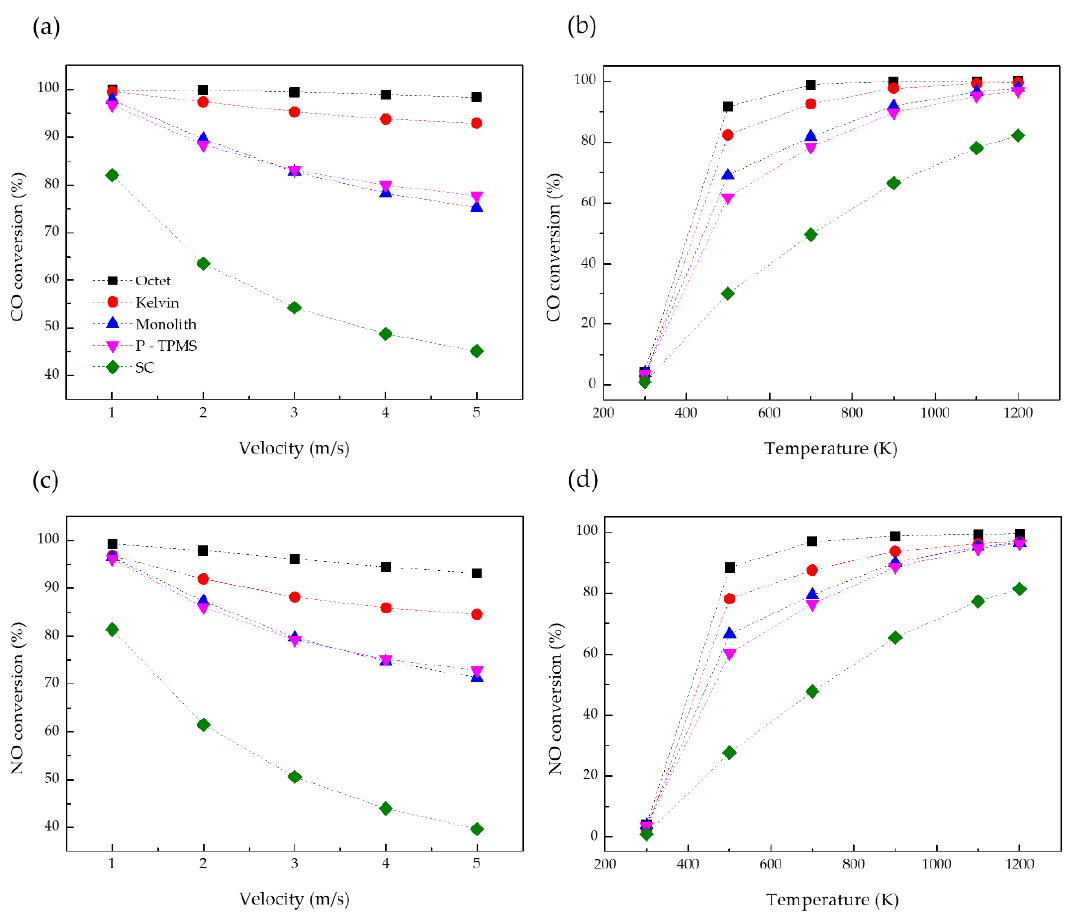
Figure 6. CO and NO catalytic conversion results: ( a ) CO conversion as a function of the exhaust gas velocity; ( b ) CO conversion as a function of the exhaust gas temperature; ( c ) NO conversion as a function of the exhaust gas velocity; ( d ) NO conversion as a function of the exhaust gas tempera- ture.